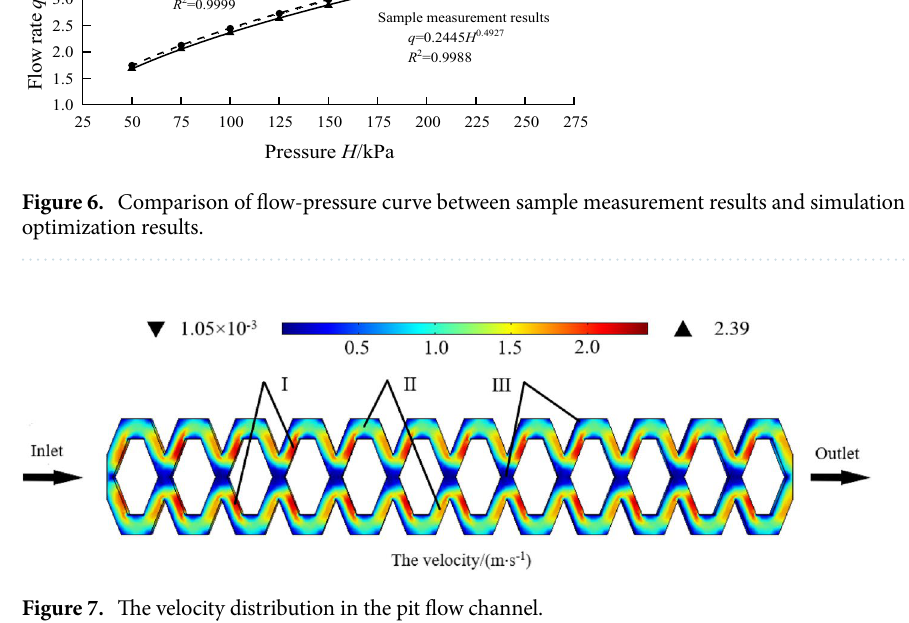
Figure 7. The velocity distribution in the pit flow